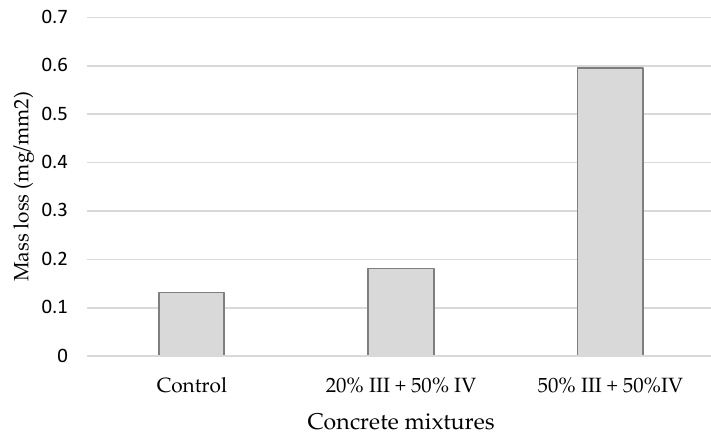
Figure 8. Results of salt-frost resistance tests.